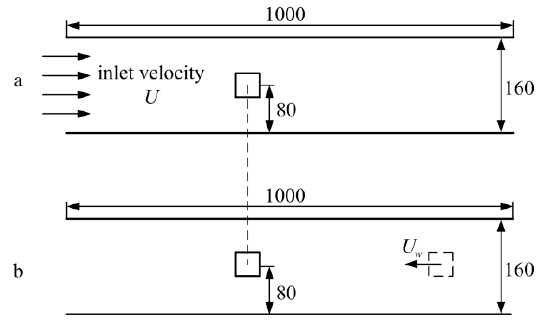
Figure 3. Physical model of square cylinder around the flow. ( a ) Inlet velocity U = 0.1, square cylinder’s velocity U w = 0 and ( b ) Inlet velocity U = 0, square cylinder’s velocity U w = 0.1.